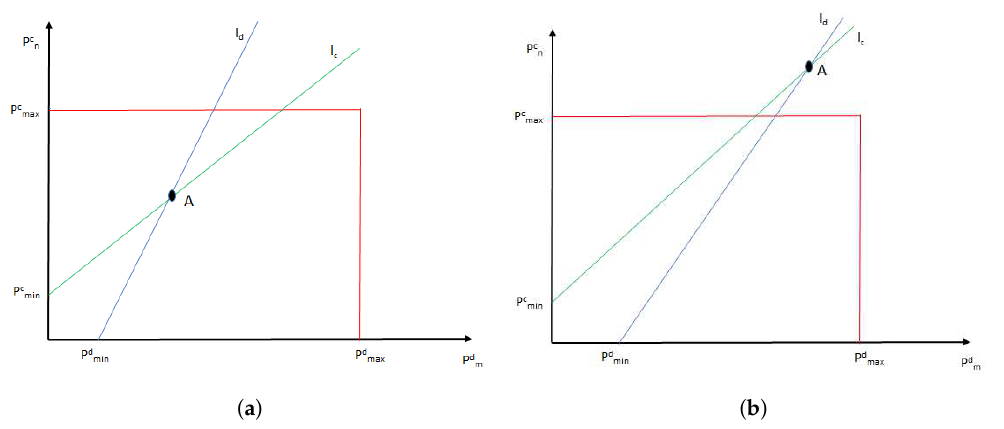
Figure 3. Representation of pairing constraints. ( a ) possible pair; ( b ) impossible